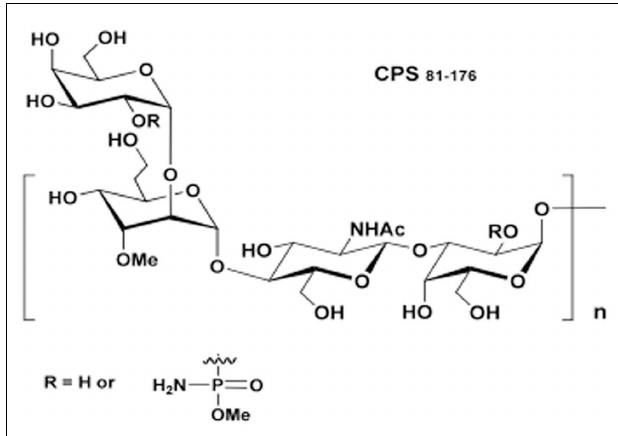
FIGURE 1 | Covalent structure of the CPS from C. jejuni strain 81–176 (serotype HS23/36). The trisaccharide repeating block is composed of → 3)-D-Gal p -(1 → 2)-3-Me-6d- α -D-altro-Hep p -(1 → 3)- β -D-Glc p NAc-(1 → . The methylated heptose is sometimes substituted by 6-deoxy- altro -heptose.The O -methyl phosphoramidate side chain is connected to the C-2 position of Gal in non-stoichiometric amounts (Kanipes et al., 2006).